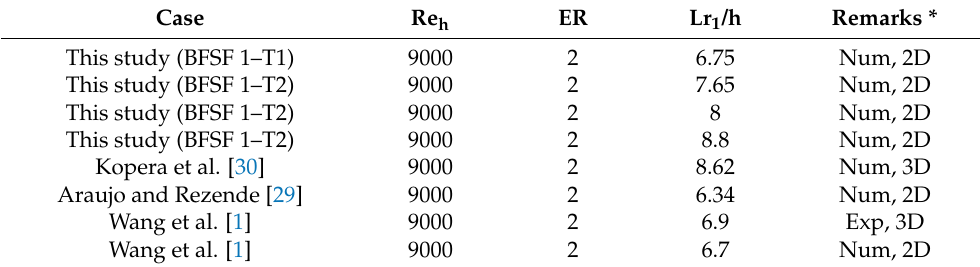
Table 9. Reattachment length in past numerical and experimental works.